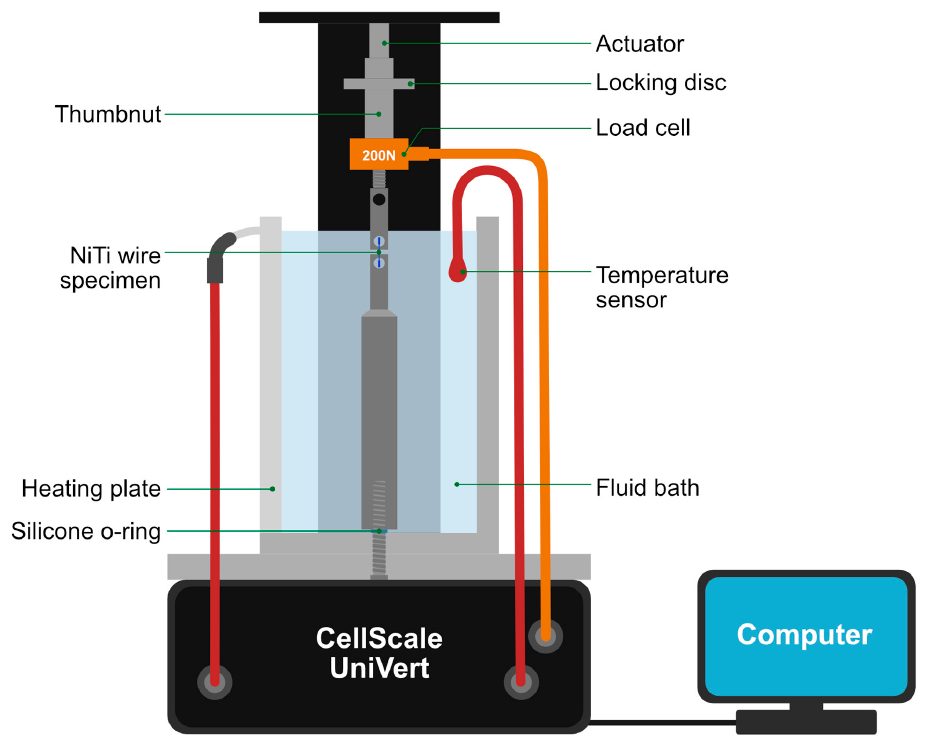
Figure 4. Schematic of UniVert microtensile